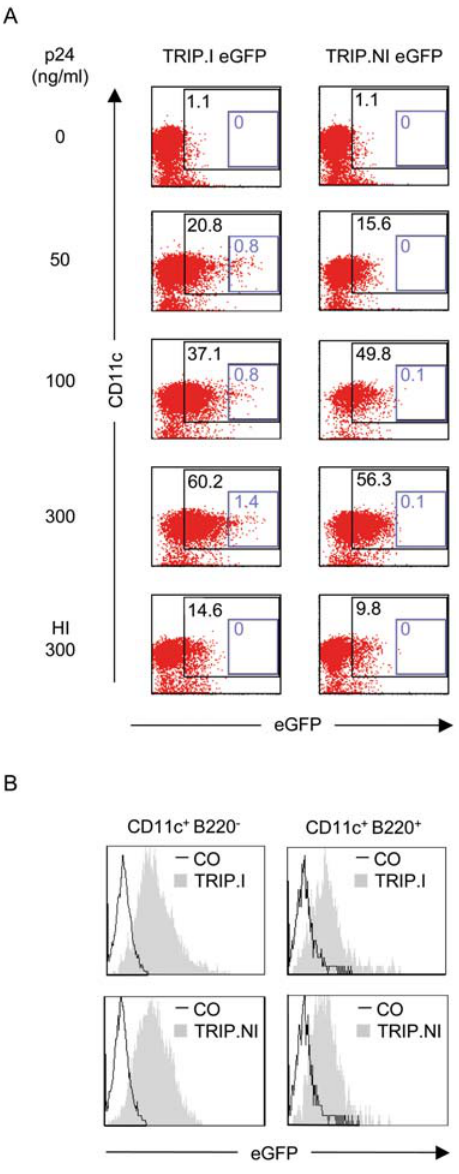
Figure 2. Lentiviral vector transduction leads to effective antigen expression both in conventional dendritic cells (cDC) and in plasmacytoid DC (pDC). (A) Dose-response transduction experiments with eGFP-integrative vectors (TRIP.I eGFP) or eGFP-non integrative vectors (TRIP.NI eGFP), heat-inactivated (HI) or not. On day 6 of differentiation, FL-DC were exposed to vector particles for 48 hours and transduction of CD11c positive cells was assessed by measuring eGFP expression by flow cytometry. Numbers indicate the percentage of CD11c + cells expressing eGFP. Blue gates delineate a DC population expressing high levels of eGFP. (B) Transduction of pDC and cDC by lentiviral vectors. Expression of eGFP by cDC (CD11c + B220 2 ) and pDC (CD11c + B220 + ) is shown. Thin lines, control cells; filled profiles, FL-DC transduced with 300 ng/ml of vector particles.